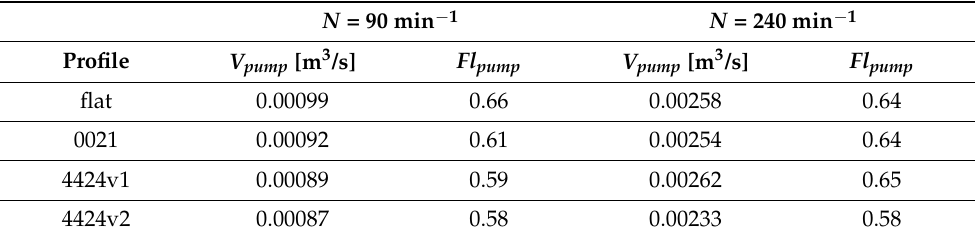
Table 4. Pumping Table 4. Pumping capacity.